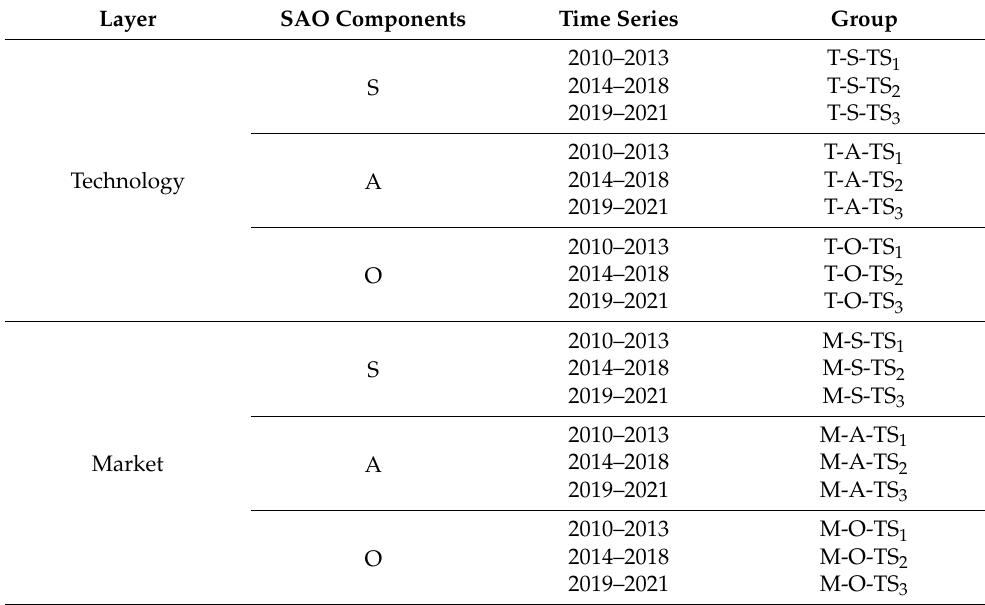
Table 4. The group result of SAO components for the technology and market layer.